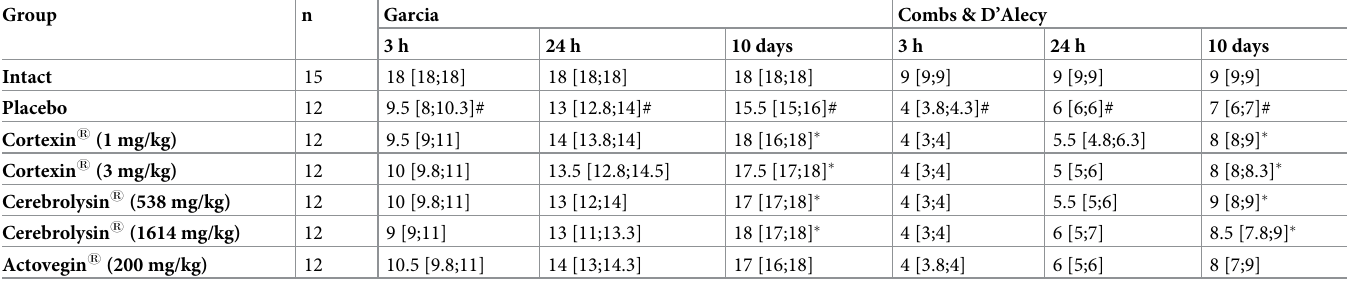
Table 1. The severity of neurological deficit according to the Garcia and Combs & D’Alecy scales, observed 3 and 24 hours after acute brain ischemia modeling, as well as after 10 days of treatment.